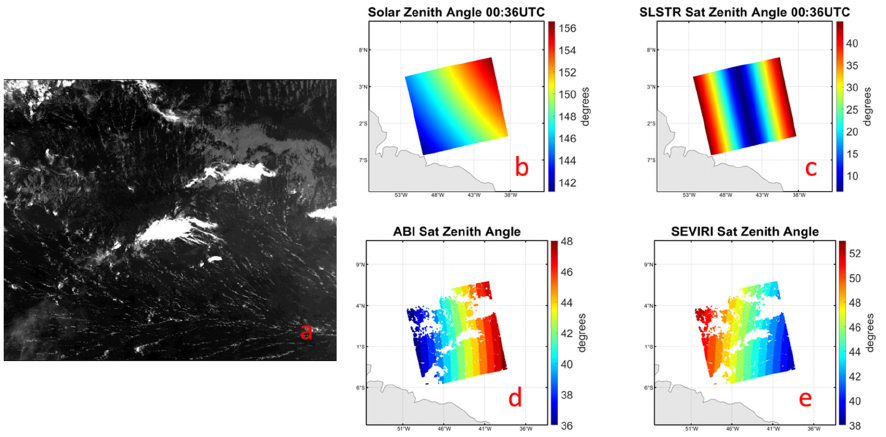
Figure 18. ( a ): SLSTR nighttime false color infrared image of the cross ‐ covered region on 27 November 2019, 00:36 UTC. ( b ): Solar zenith angles data at the same time. Corresponding SLSTR ( c ), ABI ( d ), SEVIRI ( e ) satellite zenith angles data.